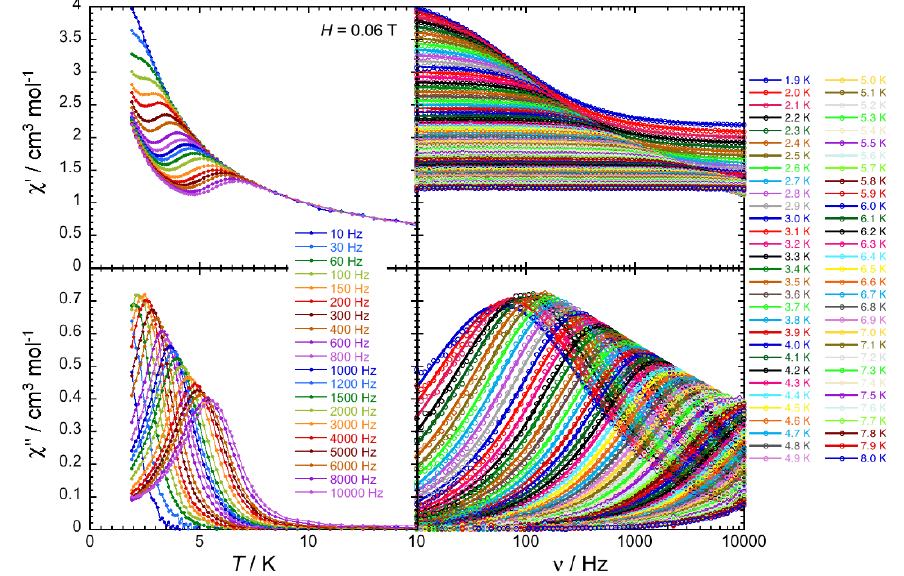
Figure 8. Frequency dependence of the real, in-phase ( χ ′, top) and imaginary, out-of-phase ( χ ", bottom) components of the ac susceptibility under an external dc field of 600 Oe (0.06 T) at the indicated temperatures for complex 3 ∙2.5MeOH. Solid lines are visual guides on the left plots, while they show the generalized Debye fit of the ac data on the right.